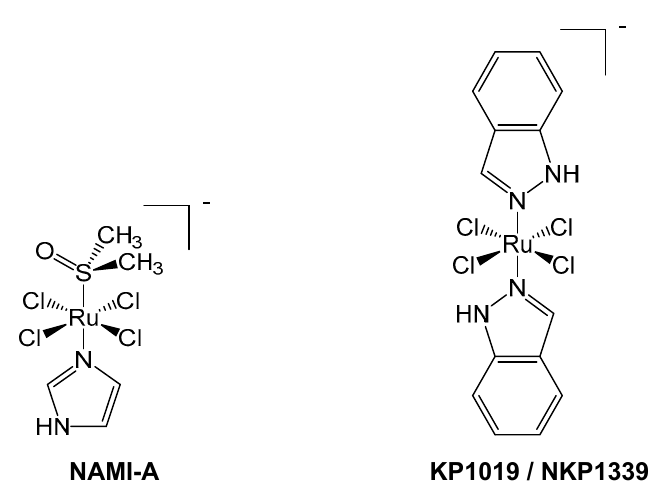
Figure 2. NAMI-A ( left ) and KP1019/NKP1339 ( right ) are octahedral Ru(III) pro-drugs, which are hypothesized to undergo an “activation by reduction” mechanism inside cells to form more active Ru(II) species.